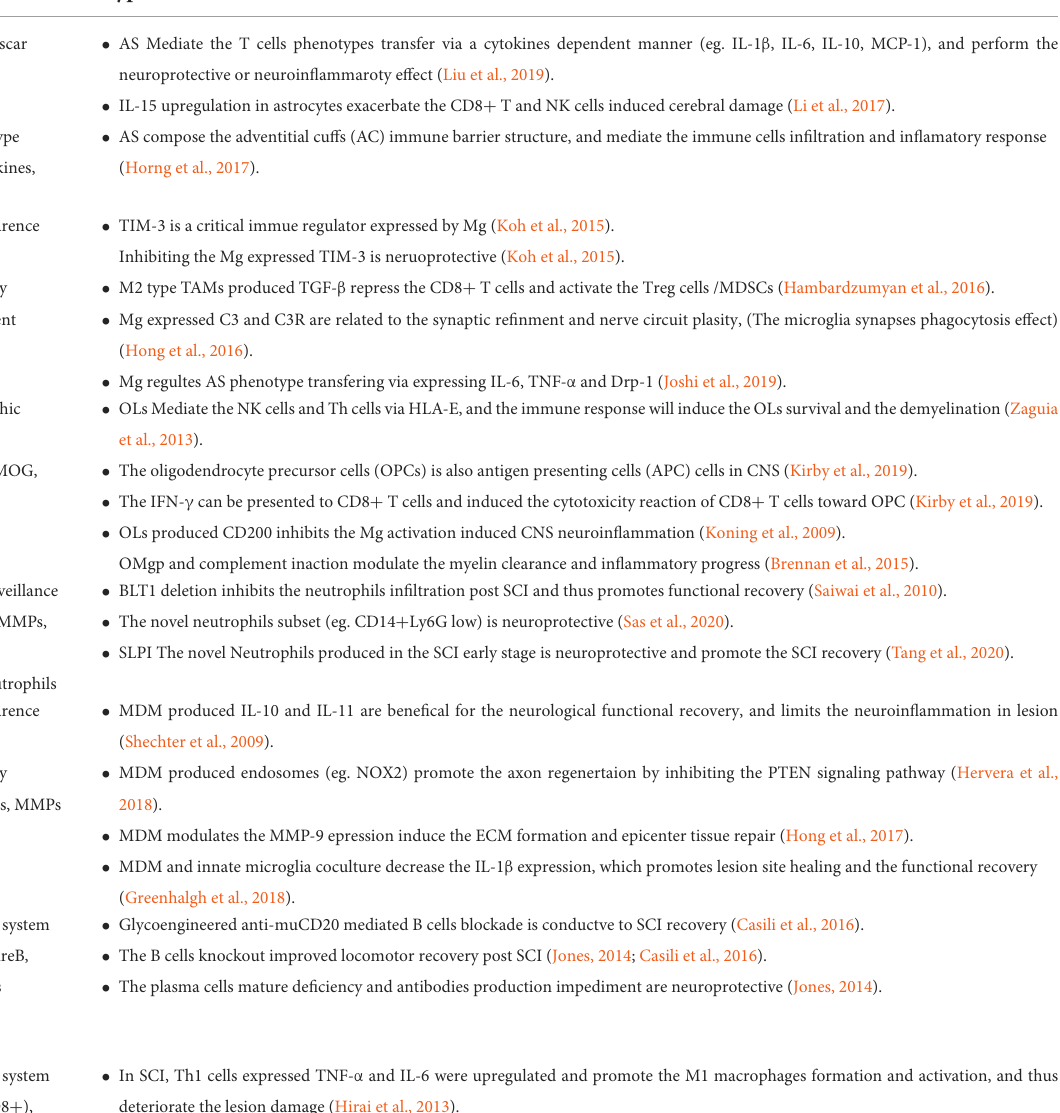
TABLE 1 SCI immunomodulation-associated cell types and